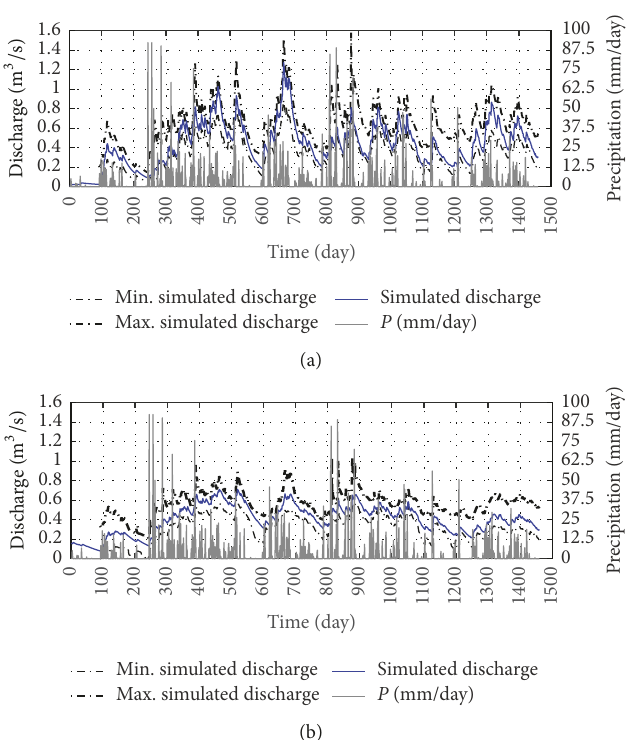
Figure 9: 𝑄 0.05 𝑆 (𝑡) and 𝑄 0.95 𝑆 (𝑡) discharge, 90% confidence interval for the simulated discharge ( 𝑄 Golubinka–Karstmod); (a) linear, (b) nonlinear.